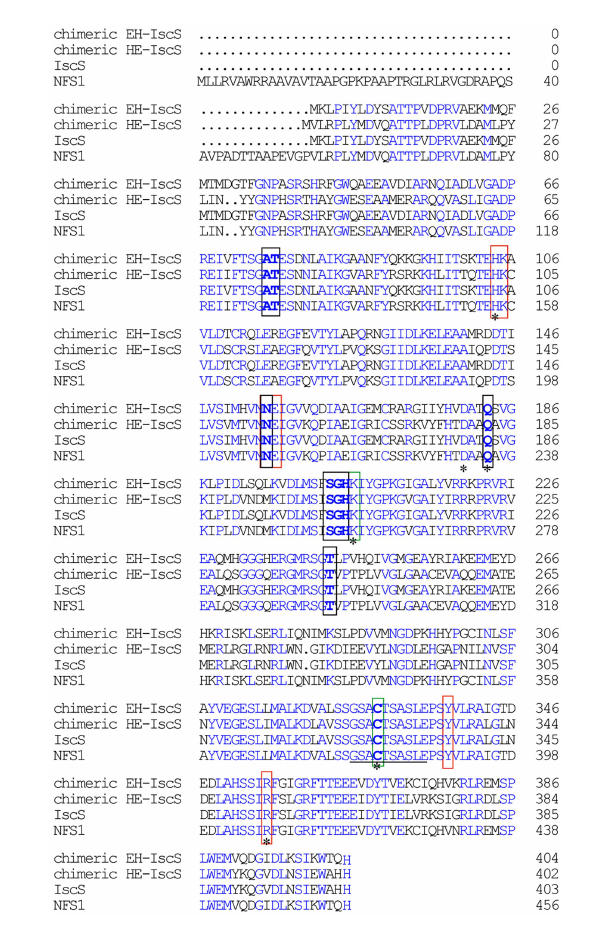
FIGURE 1 Sequence alignment of Escherichia coli IscS, human NFS1, chimeric CD EH-IscS, which was constructed by fusing the N-terminal domain of E. coli IscS with the C-terminal domain of human NFS1, and chimeric CD HE-IscS, which was constructed by fusing the N-terminal domain of NFS1 (55–457) with the C-terminal domain of IscS. Amino acid sequence alignment was performed with DNAMAN . Blue areas indicate identity, black frames indicate the conserved pyridoxal 5 ′ -phosphate (PLP) binding sites, and red frames represent the pocket. A line (325– 334) indicates the mobile active site loop of IscS that is proposed to be involved in the sulphur transfer. The green frames represent two highly conservative amino acid residues of IscS. Mutated amino acid residues (His104, Asp180, Gln183, Lys206, Cys328, and Arg354) are marked with an